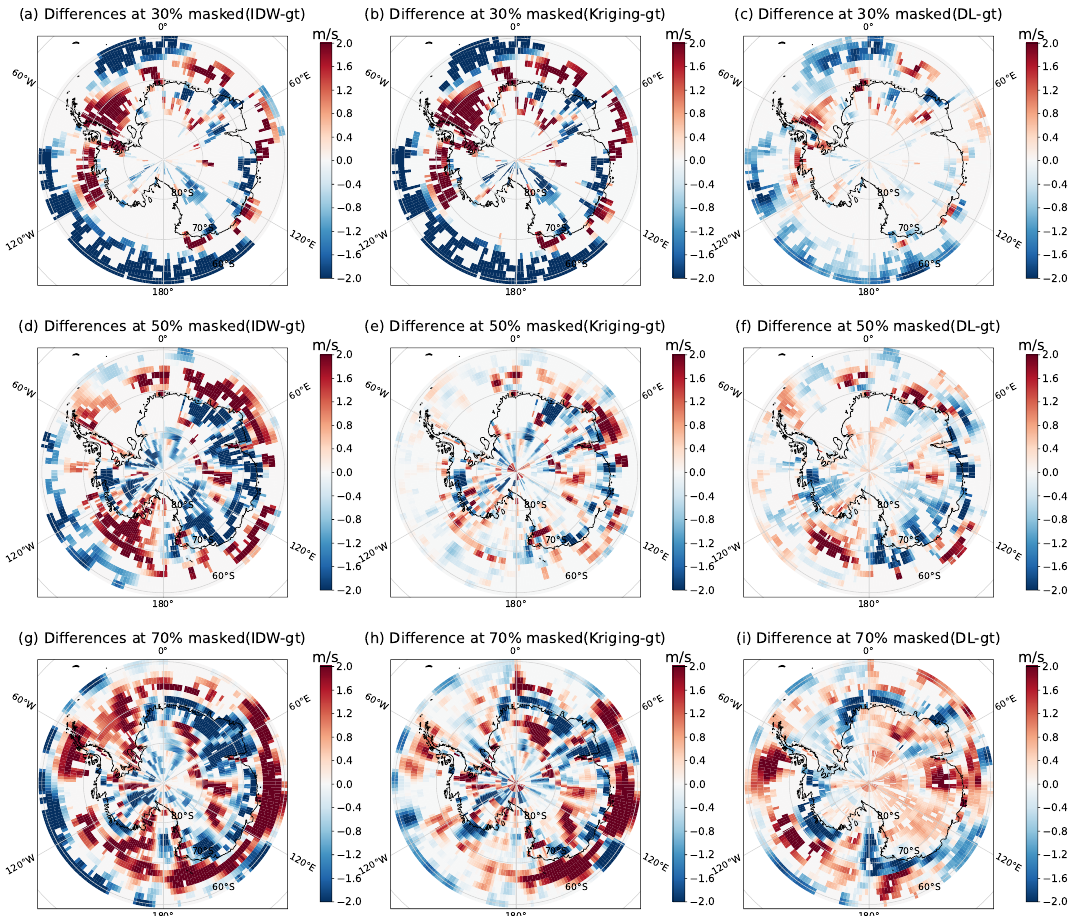
Figure 9. Differences between the reconstructed wind speed of IDW ( a , d , g ), Kriging ( b , e , h ) and RFR ( c , f , i ) and the ground truth with 30%, 50% and 70% missing rates,